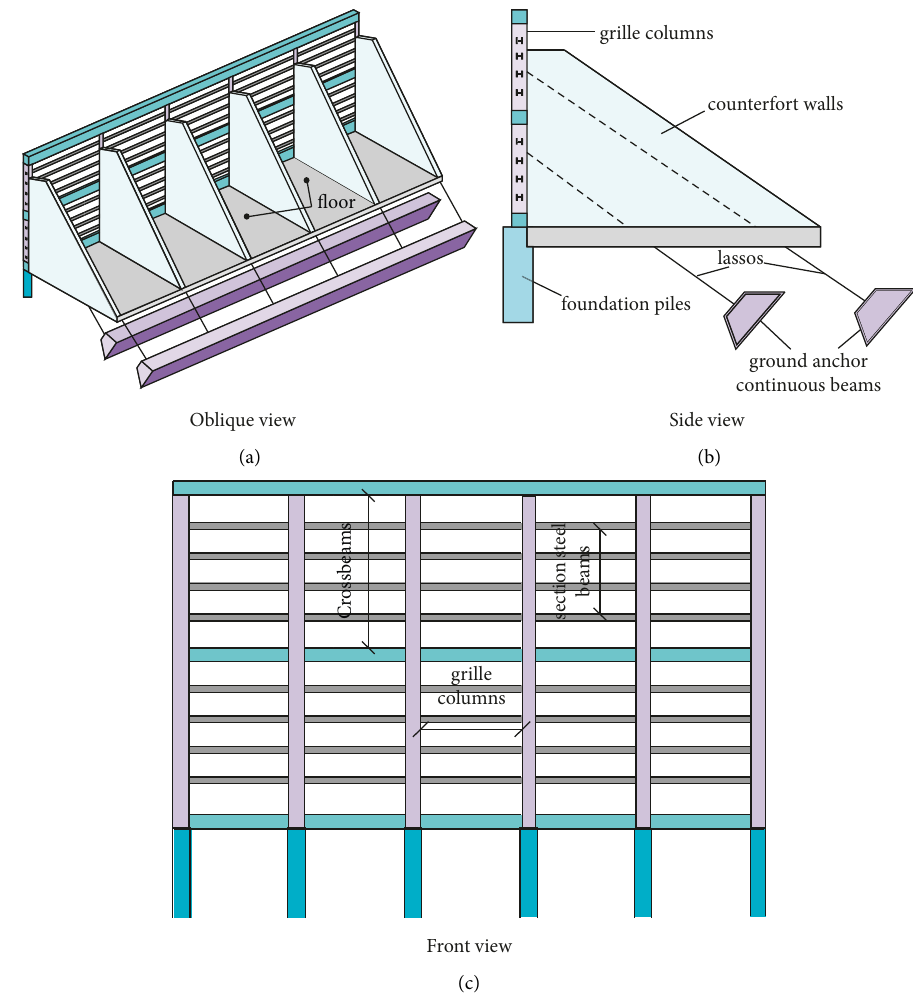
Figure 1: Schematic diagram of new grille-dam. (a) Oblique view, (b) side view, and (c) front